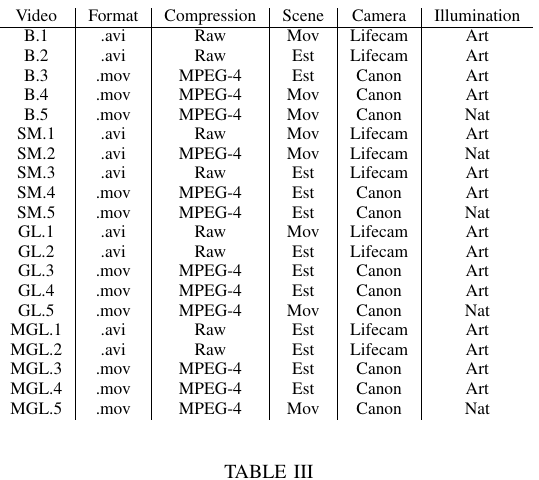
TABLE III T EMPLATE 1: % OF FRAMES WITH ENOUGH GOOD